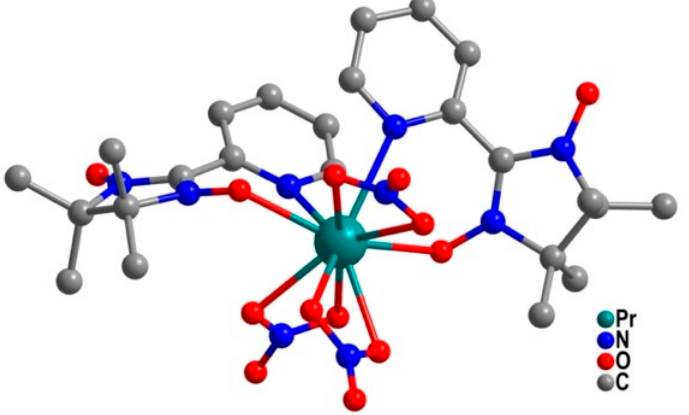
Figure 23. Molecular structure of complex 38 . The structure was re-drawn from Reference [59] with permission from the Elsevier Ltd.